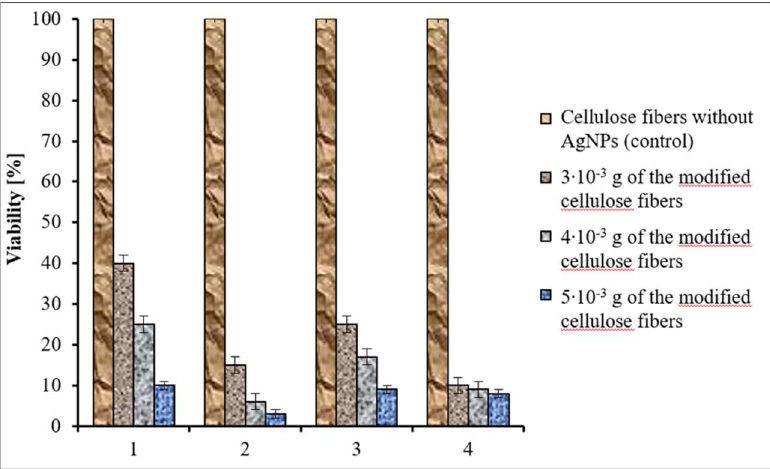
Figure 19. The effect of the cellulose fibers modified with 3% of AgNPs after 30 laundering cycles on the viability of S. aureus (1) , E. coli (2 ) , A. baumannii , (3) and C. albicans (4)